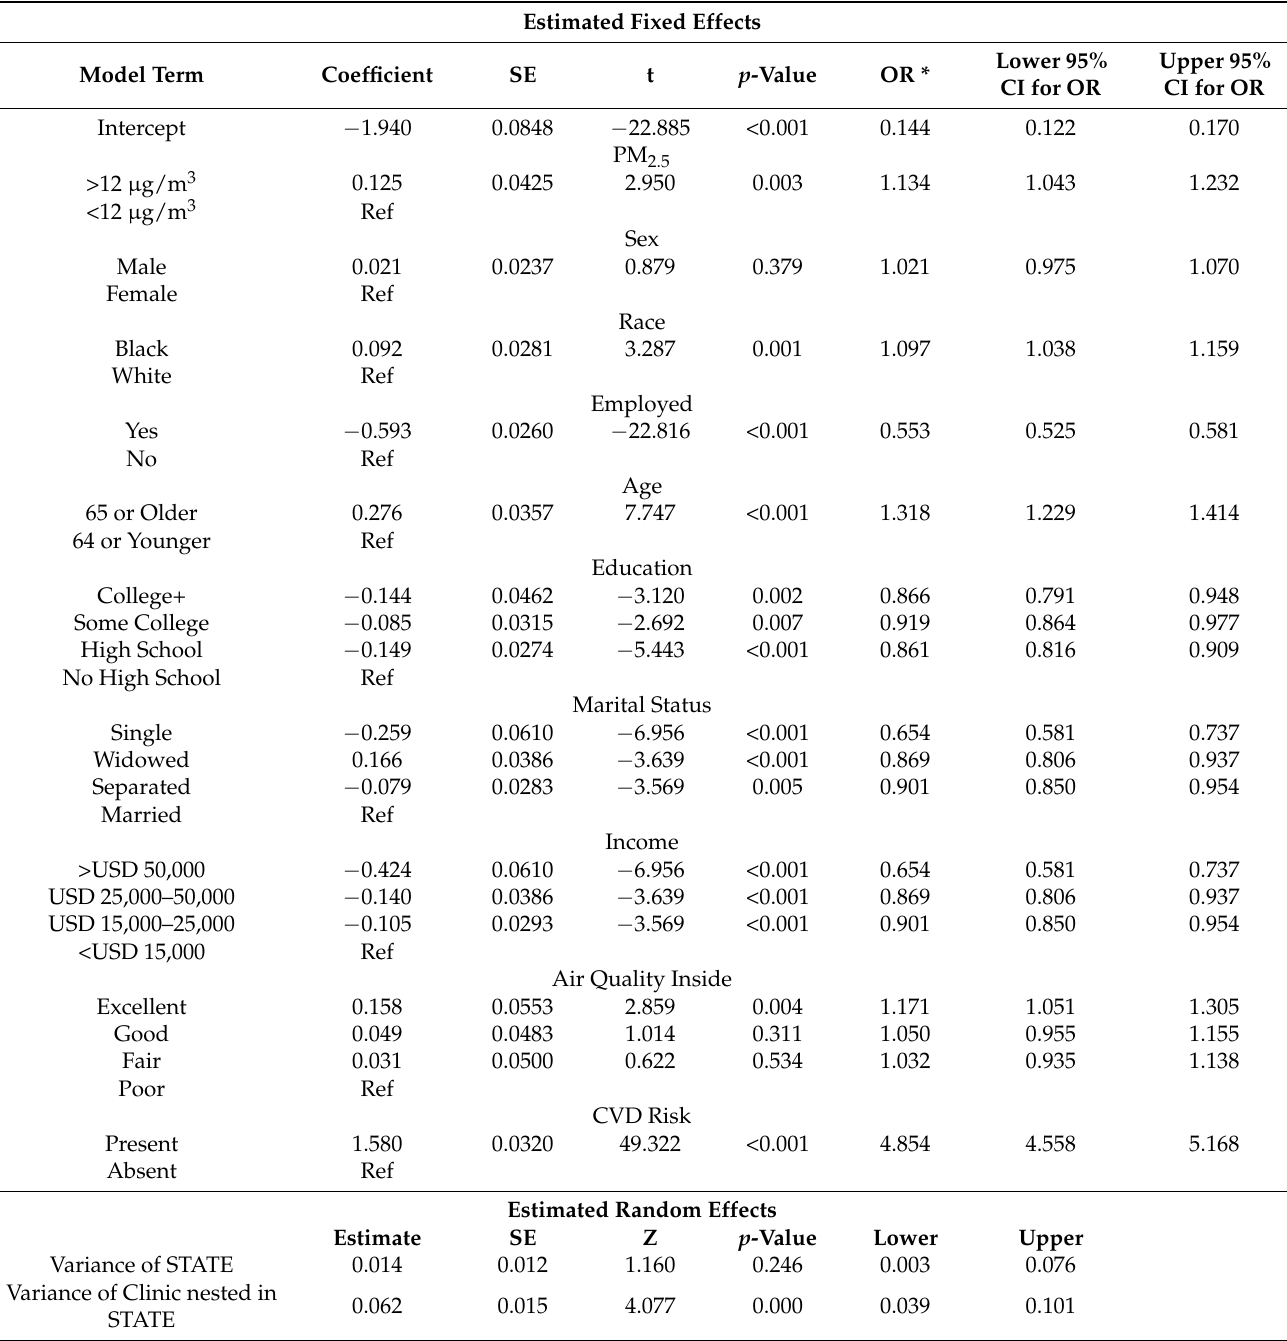
Table 3. Multilevel Logistic Regression Model Estimated Fixed Effects for Reported Cardiovascular Disease at Enrollment by SCCS